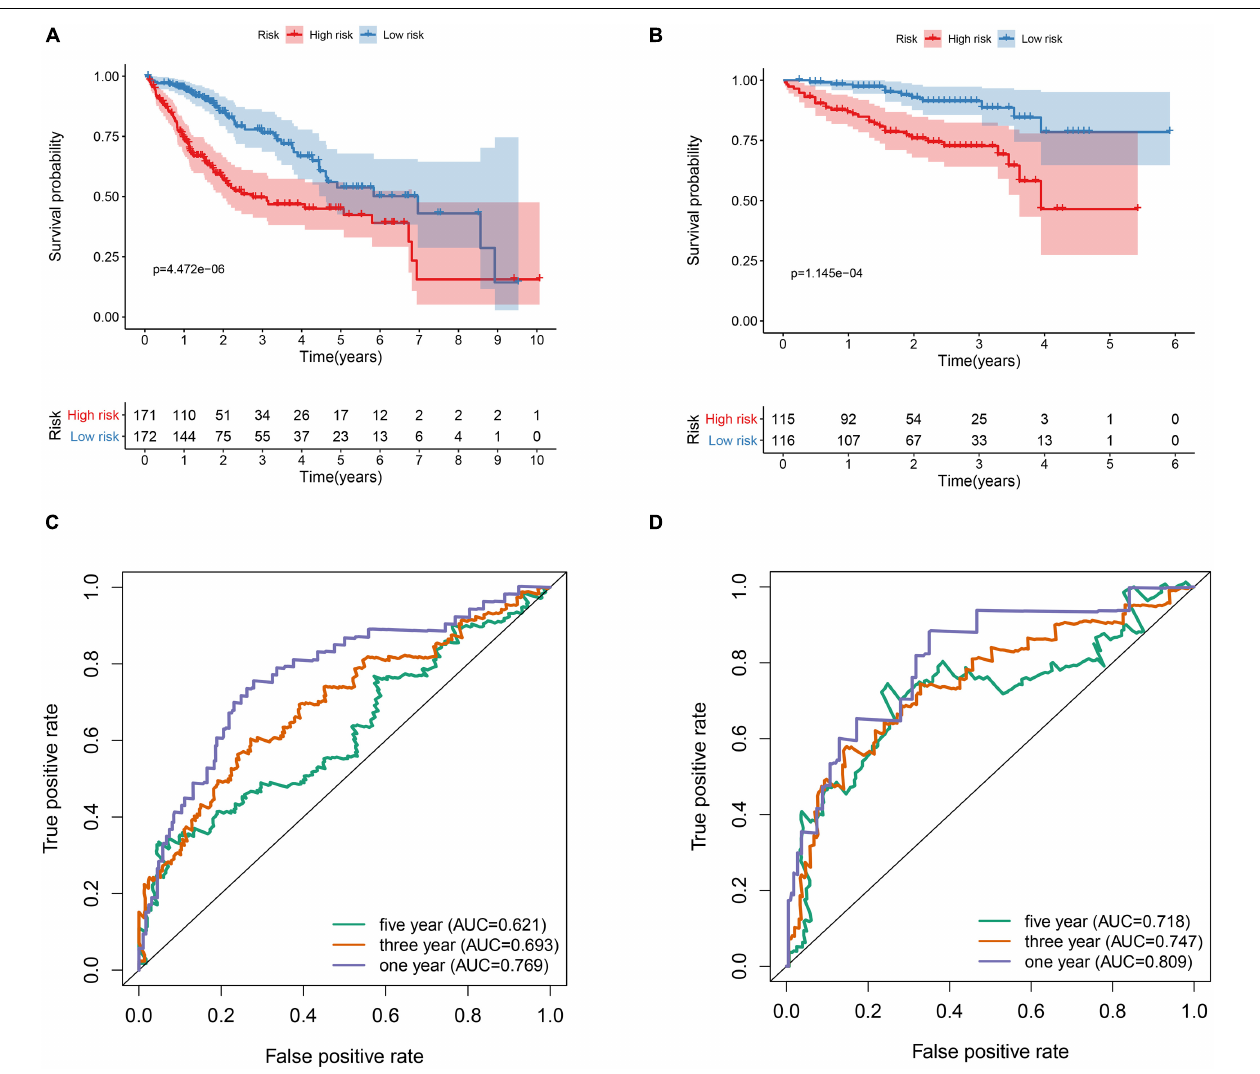
FIGURE 3 | Prognostic value of the hypoxia risk signature in HCC. (A) Kaplan-Meier curve analysis of the hypoxia risk signature in the TCGA dataset. (B) Kaplan-Meier curve analysis of the hypoxia risk signature in the ICGC dataset. (C) ROC curve analysis of the hypoxia risk signature of the 1-, 3-, and 5-year in the TCGA dataset. (D) ROC curve analysis of the hypoxia risk signature of the 1-, 3-, and 5-year in the ICGC dataset.